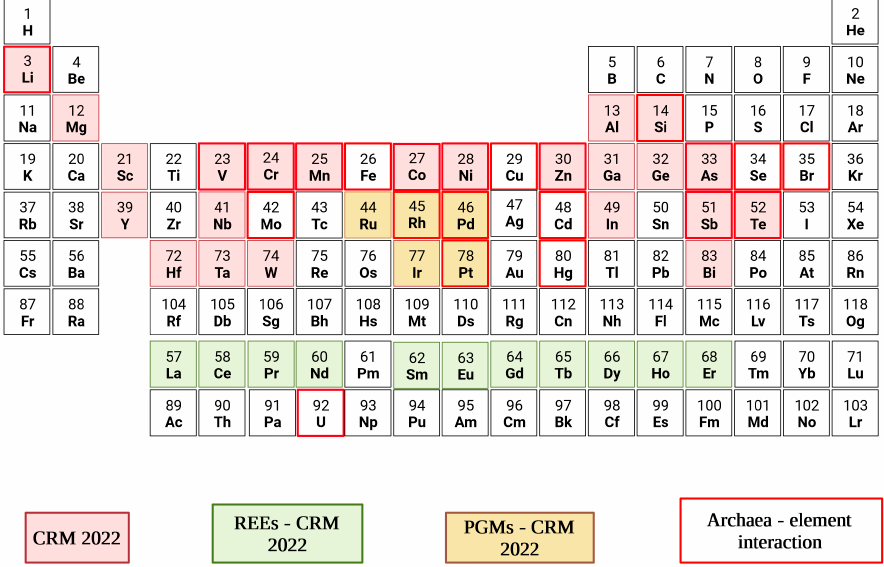
Figure 2. Periodic table of elements categorised as Critical Raw Materials in 2022, comprising PGMs and REEs as listed in Table S1 [13,14]. The red squares represent archaea-element interactions described in the present work.